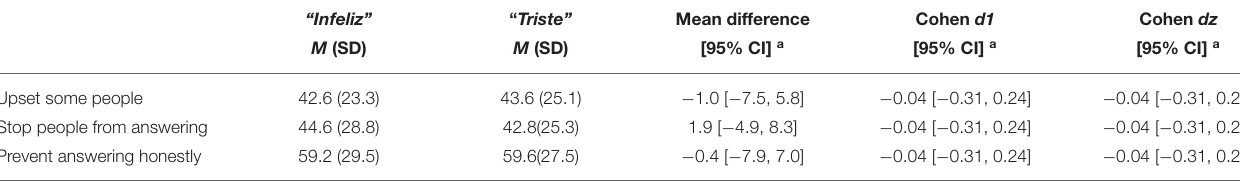
TABLE 2 | Paired differences between “ infeliz ” and “ triste ” for ratings (substudy 2). “Infeliz” “